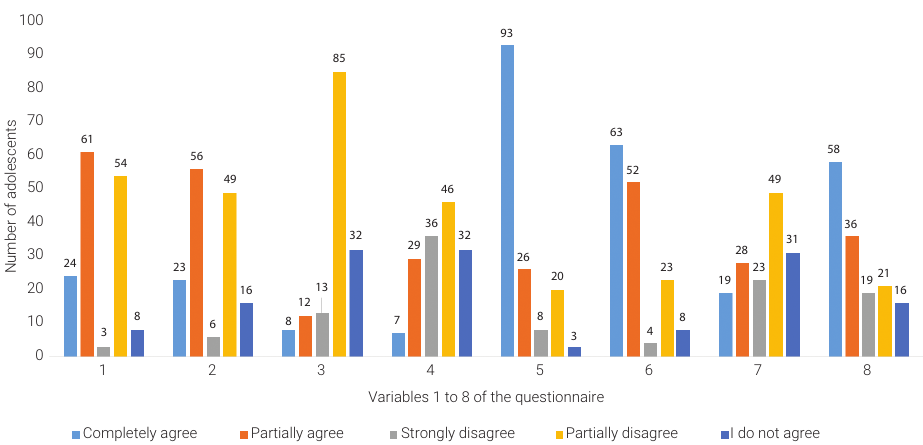
Figure 4. Graphical representation of number of adolescents of G2 who answered the 8 variables of the questionnaire (1 to 8) according to the Likert scale for males.